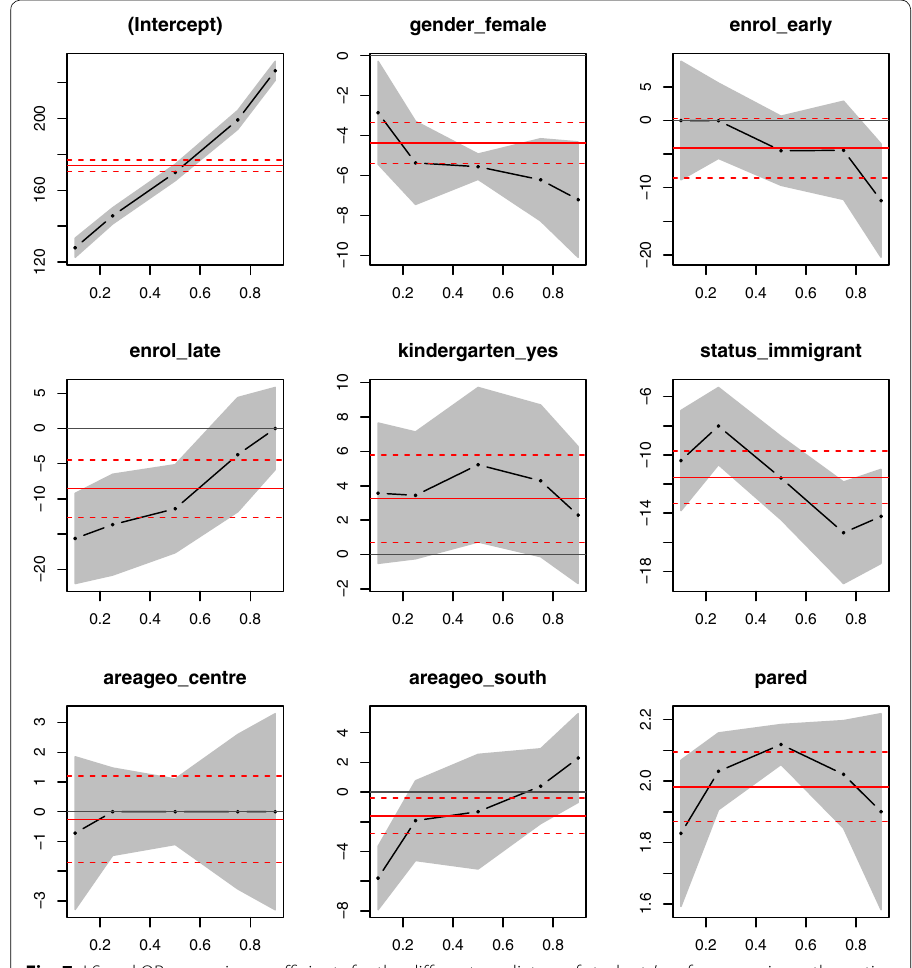
Fig. 7 LS and QR regression coefficients for the different predictors of students’ performance in mathematics: second-graders